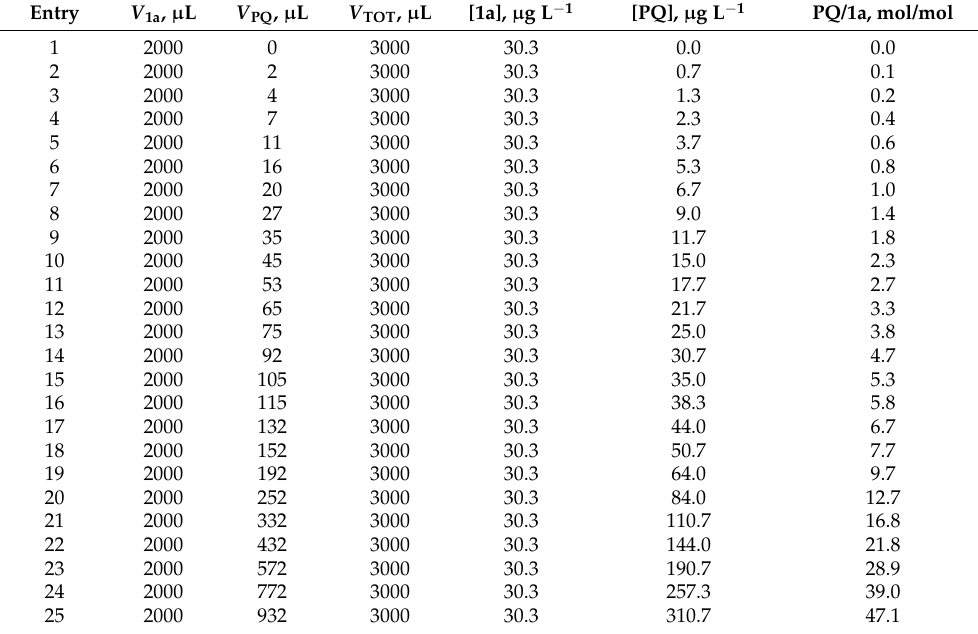
Table 1. Experimental data for the determination of spectra reported in Figure 3. The V 1a and V PQ volumes refer to an initial 1a solution with a concentration of 45.5 µ g L − 1 and paraquat, PQ, solution with a concentration of 1000 µ g L − 1 , respectively. The final volume of each solution was made up to a total volume of 3000 µ L by fixing with the solvent